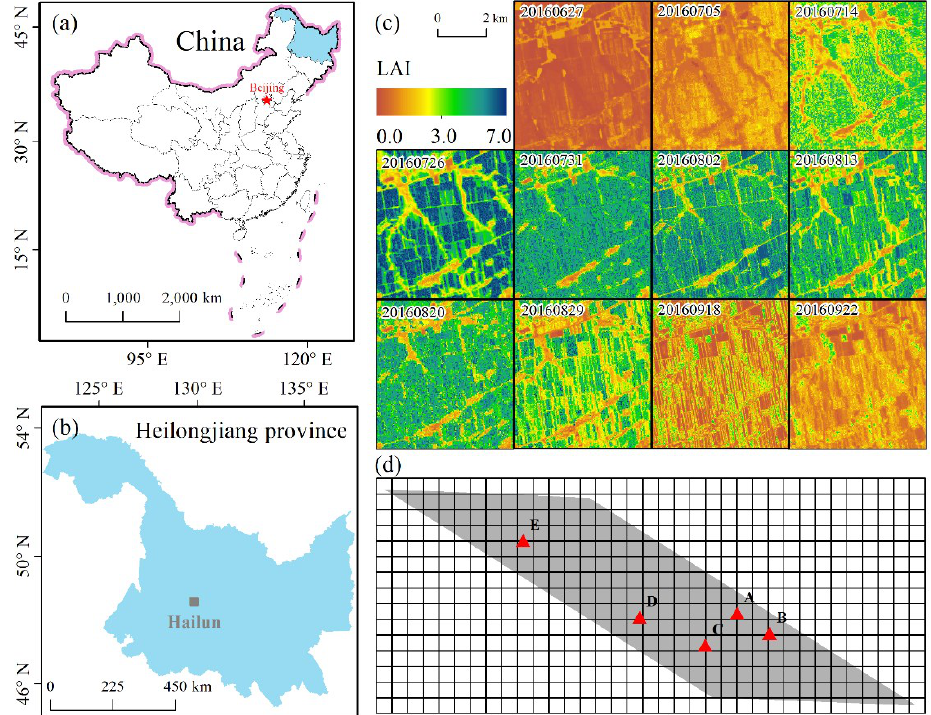
Figure 1. Study area. ( a , b ) Geographical location; ( c ) 11 LAI reference maps with the original UTM projection and the area of 30 km 2 at the 30 m spatial resolution in 2016 (the text on the top of every image represents the date of the LAI reference map); ( d ) Study-area size, including 15 × 35 grids at 500 m resolution in the sinusoidal projection. The grey shade indicates the position of LAI reference maps in the sinusoidal projection and the red triangles represent the field